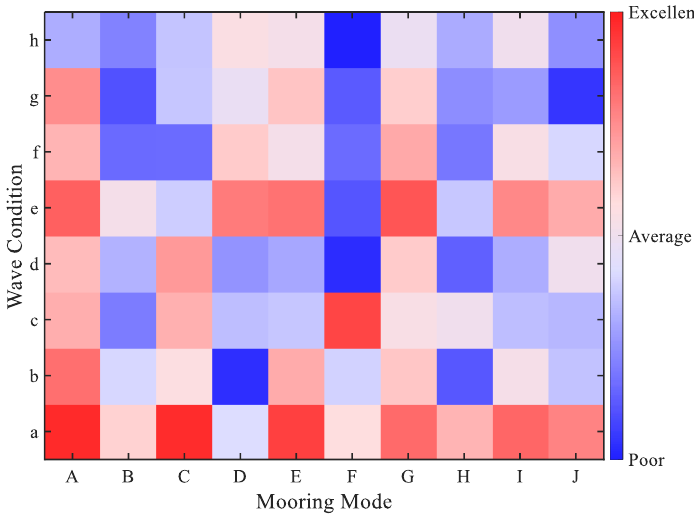
Figure 19. The cloud chart of the maximum tension of the anchor lines.